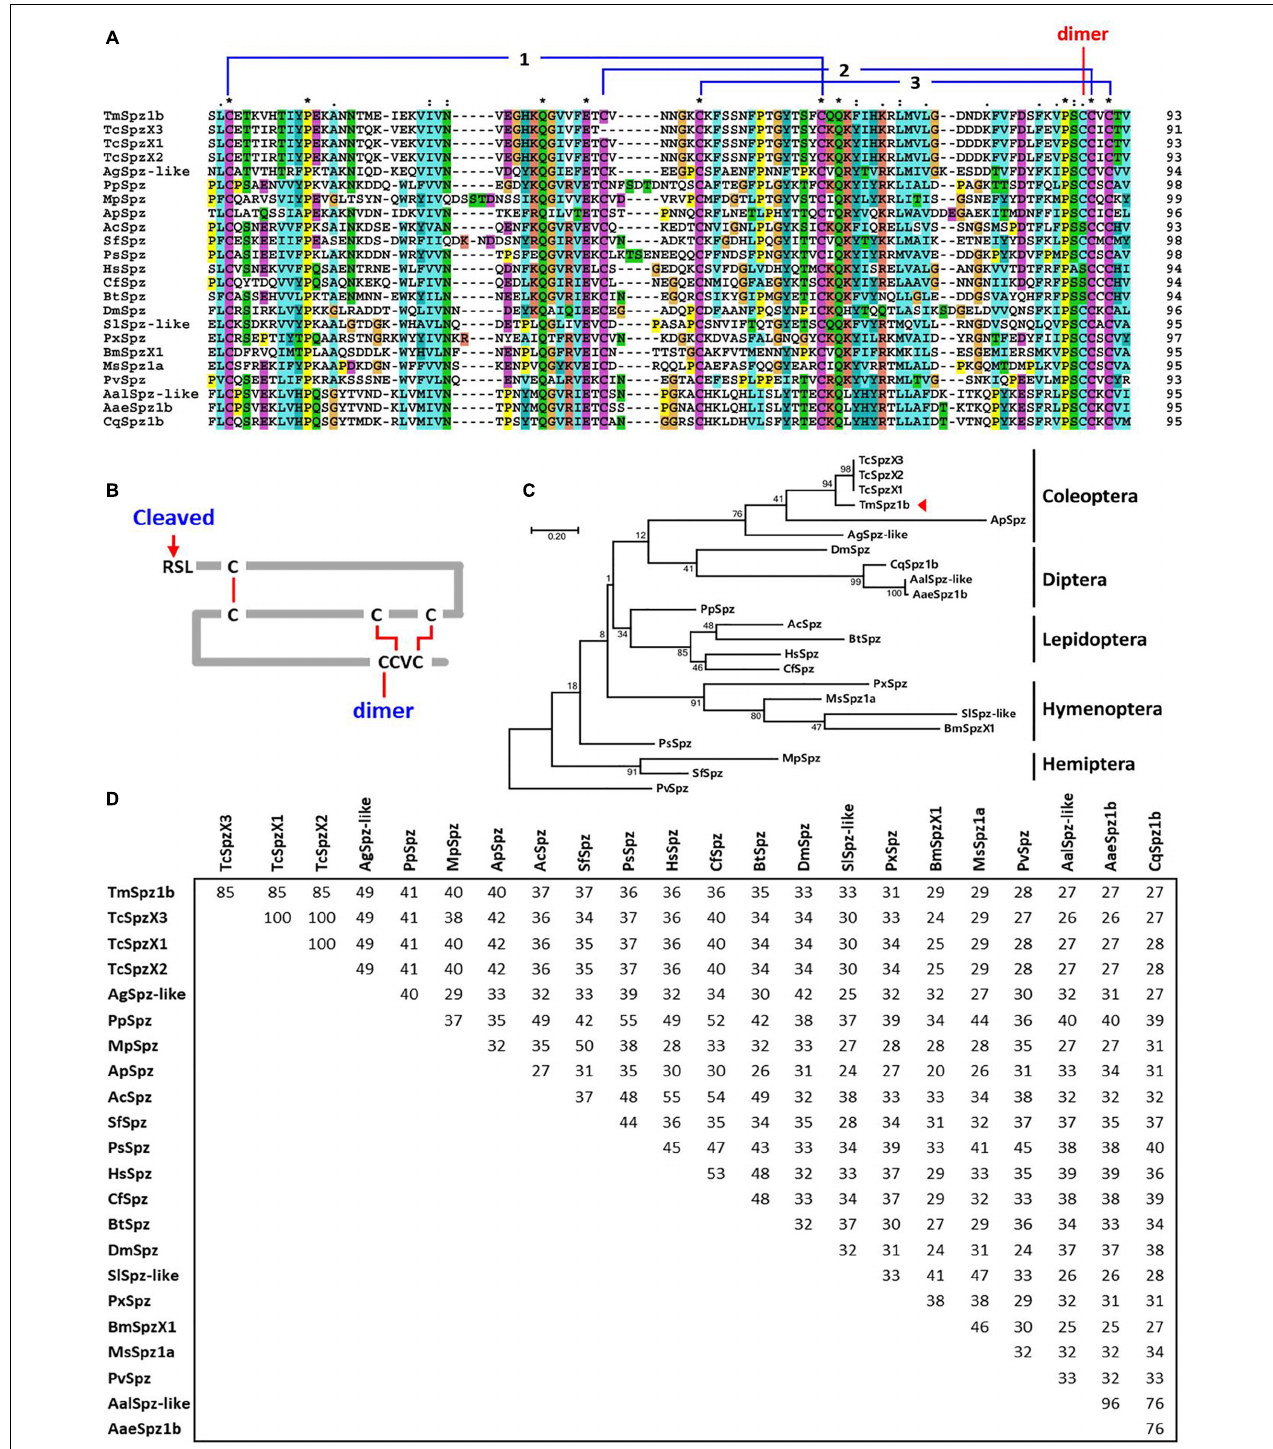
FIGURE 2 | Multiple sequence alignment and phylogenetic analyses of Spätzle proteins. (A) Multiple sequence alignment of the spätzle domain in Spätzle proteins. A high degree of conservation is evident in the spätzle domain. The conserved cysteine residues forming the three disulfide bonds are shown. The cysteine involved in the dimer formation is also denoted. (B) Deduced cystine-knot domain of Tm Spz1b. The six cystine residues form three disulfide bridges, and the one extra cystine residue may interact with the other active form of Spätzle protein. (C) Phylogenetic tree of Spätzle proteins. Tm Spz1b is located on the same branch occupied by Tc SpzX1, Tc SpzX2, and Tc SpzX3. (D) Percentage identity of Tm Spz1b with its orthologs. The Penaeus vannamei spätzle protein ( Pv Spz) sequence